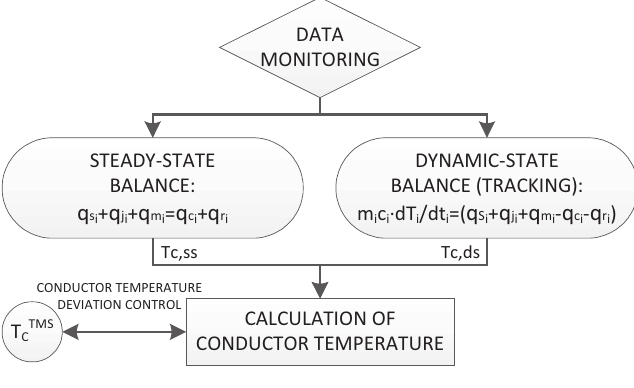
Figure 1. Conductor heat balance flow